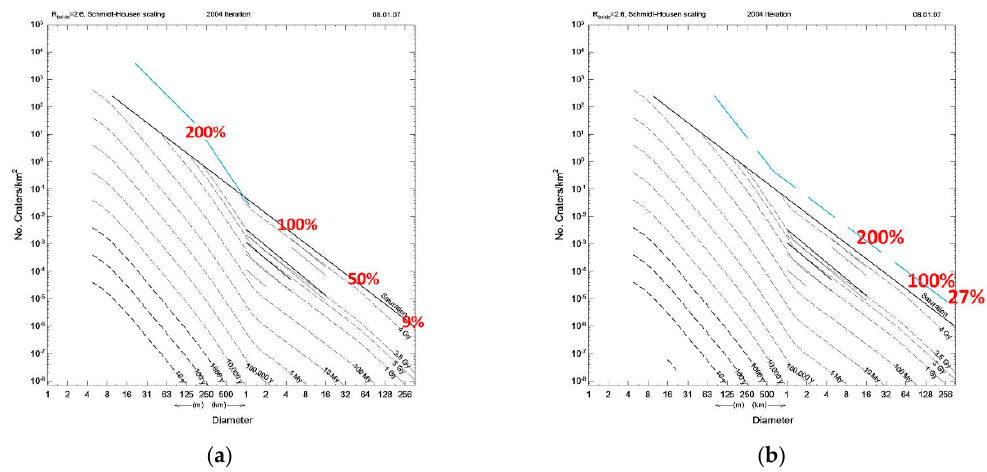
Figure 15. This 2004 iteration of the isochron diagram schematically illustrates the method for deriving multikilometer deep regolith on old surfaces. The “%” figures indicate the percentage of the surface covered by craters larger than the indicated diameter. ( a ) This figure shows that for a surface 4 Ga in age (blue line), craters in the largest single bin cover only 9% of the surface, but craters of diameter as large as D ~ 4–8 km cumulatively cover 100% of the surface, and craters of a few hundred meters cover a total of 200% of the surface. ( b ) If impact rates were hundreds of time greater before 4 Ga ago than at present (as discussed in the text), supersaturation of the lunar surface is virtually assured. In a hypothetical case where total cratering (blue dashed line) reaches ~8 × the saturation level (plausibly within few hundred Ma on a surface formed > 4 Ga ago; see Figure 14), 100% saturation is reached among 100 km-scale craters During supersaturation, observed crater counts rarely rise above 2 × the saturation line, because of crater overlap, but we can plot the total number of craters formed (dashed line) and study the consequences. If 100 to 200% of the area is covered by craters of D ≳ 10 to 100 km, implying megaregolith depths in the range of at least ~3 km to as much as ~30 km. Deepest layers of megaregolith may be consolidated into coherent breccias.